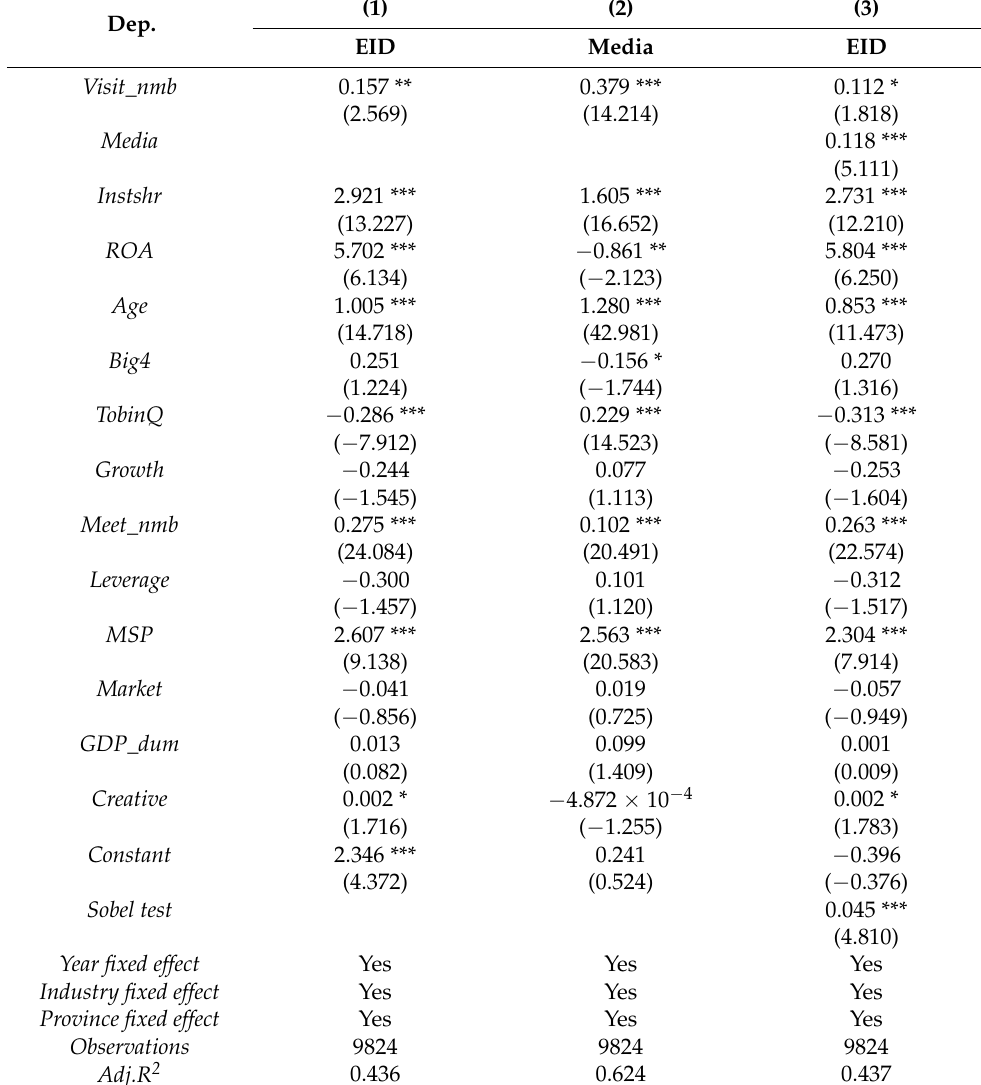
Table 5. Mechanism analysis results of the analyst site visits on CEID. Dep.